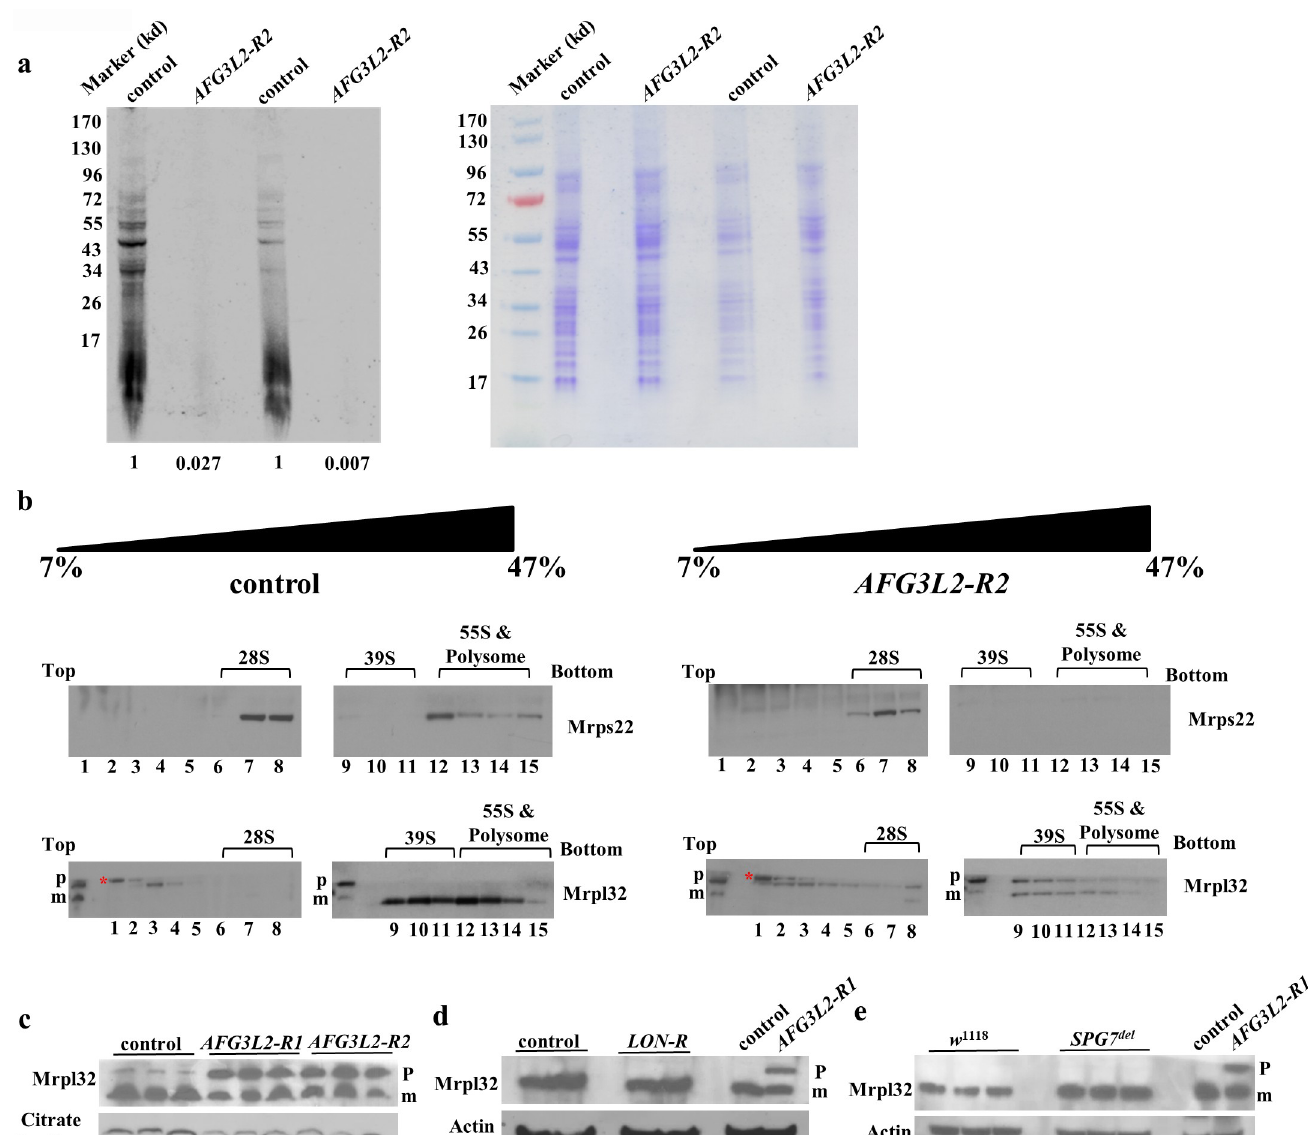
Fig 5. Afg3l2 deficiency impairs mitochondrial ribosome assembly and translation. a. Mitochondria from control (UAS- LUCIFERASE RNAi/da-Gal4) and AFG3L2 -deficient (UAS- AFG3L2-R2 RNAi/da-Gal4) pupae were labeled with 35 S-methionine for 1 h, then homogenized and subjected to SDS-PAGE. The left panel shows the 35 S-labeled proteins, while the right panel shows the Coomassie staining pattern using the same samples. The Coomassie-stained samples were used to normalize protein loading (control samples defined as 1.0). b. Sucrose density gradient centrifugation was performed using mitochondrial protein extract from control (UAS- LUCIFERASE RNAi/da-Gal4) and AFG3L2 -deficient (UAS- AFG3L2-R2 RNAi/da-Gal4) animals and fractions were subjected to immunoblotting using antisera against Mrps22 and Mrpl32. Red asterisks denote a non-specific band. c. Mrpl32 processing was analyzed by subjecting a mitochondrial protein extract from control (UAS- LUCIFERASE RNAi/da-Gal4) and AFG3L2 -deficient (UAS- AFG3L2-R1 RNAi; da-Gal4 or UAS- AFG3L2-R2 RNAi/da-Gal4) pupae to western blot analysis using an antiserum against Mrpl32. Citrate synthase was used as a loading control. The ‘p’ and ‘m’ denote the pre-sequence containing form of Mrpl32 and the mature form of Mrpl32 lacking the presequence, respectively. d. Mrpl32 processing was analyzed as in (c) using protein extracts from control (UAS- LUCIFERASE RNAi/da-Gal4) and LON -deficient (UAS- LON-R RNAi/da-Gal4) pupae. e. Mrpl32 processing was assessed as in (c) and (d) using protein extracts from control ( w 1118 ) and SPG7 del flies. A cell lysate from AFG3L2 -deficient (UAS- AFG3L2-R1 RNAi; da-Gal4) pupae is shown in (d) and (e) to illustrate the locations of the pre-sequence containing form of Mrpl32 (P) and the mature form of Mrpl32 lacking the presequence (M). Actin was used as a loading control in (d) and (e) .